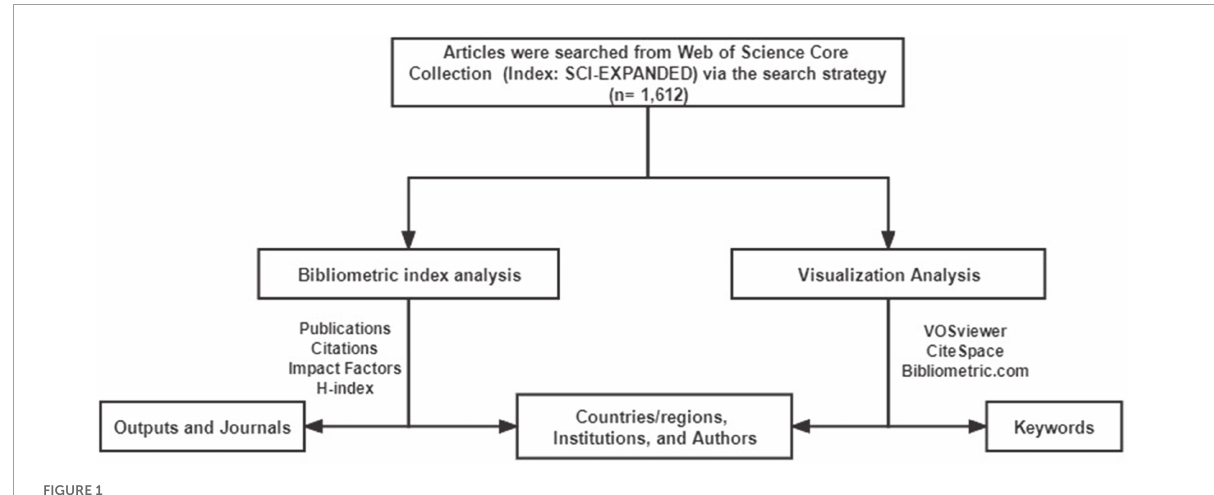
FIGURE1 Flow chart of literature research, bibliometric analysis, and visualization analysis.